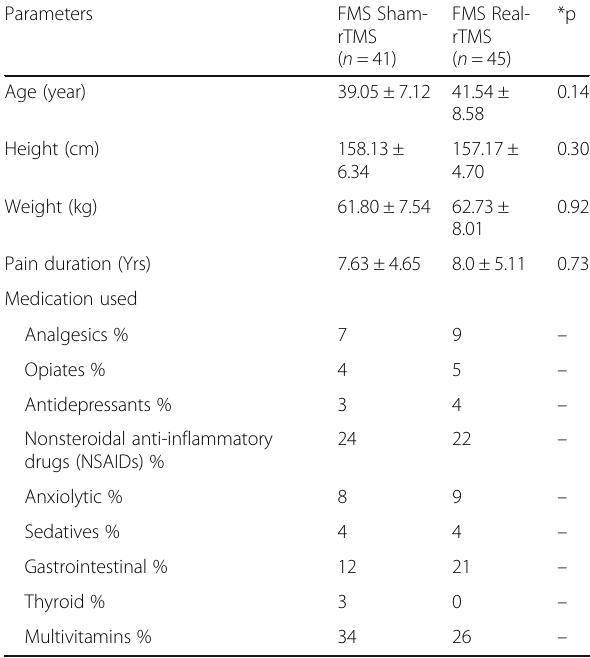
Table 1 General characteristics and medication details of FMS Sham-rTMS and Real-rTMS